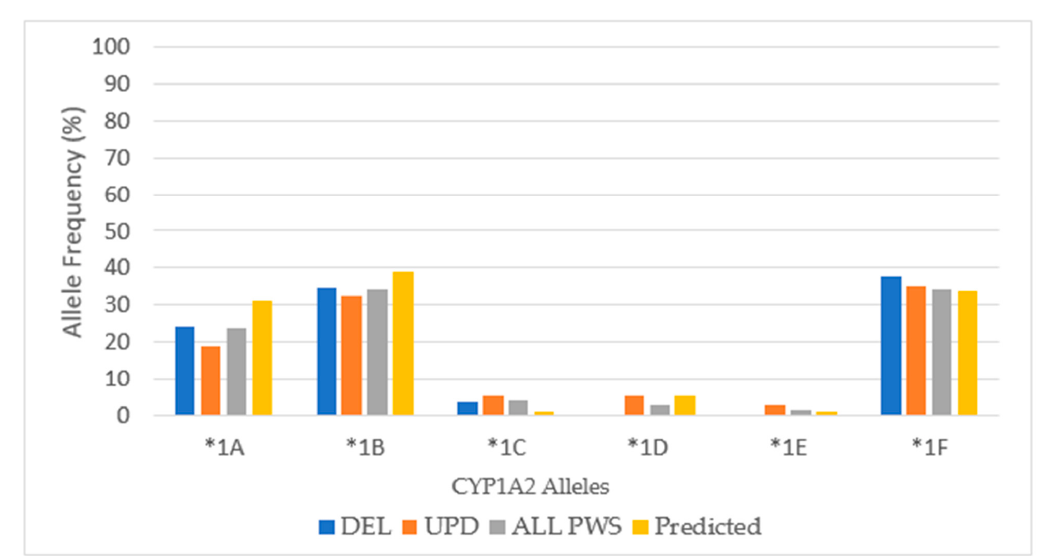
Figure 11. CYP1A2 allelic frequencies in PWS DEL ( n = 14), UPD ( n = 16) and combined cohort (ALL PWS, n = 35) compared to normative Caucasian predicted values [37,38]. CYP1A2*1A and *1B have normal function and CYP1A2*1C has decreased function.